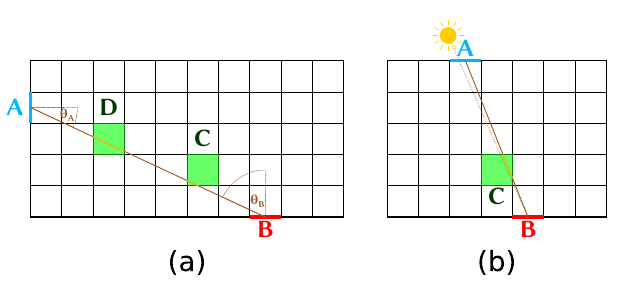
Figure 1. (a) View factor calculation (2-D simplification); (b) direct solar